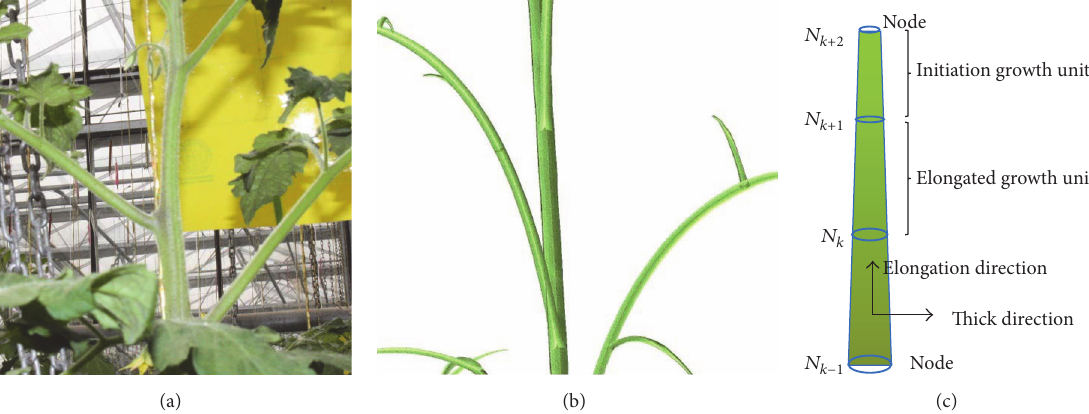
Figure 1: Modeling tomato stems with cylinders. (a) Stem photo. (b) Stem model. (c) Growth units and growth directions.